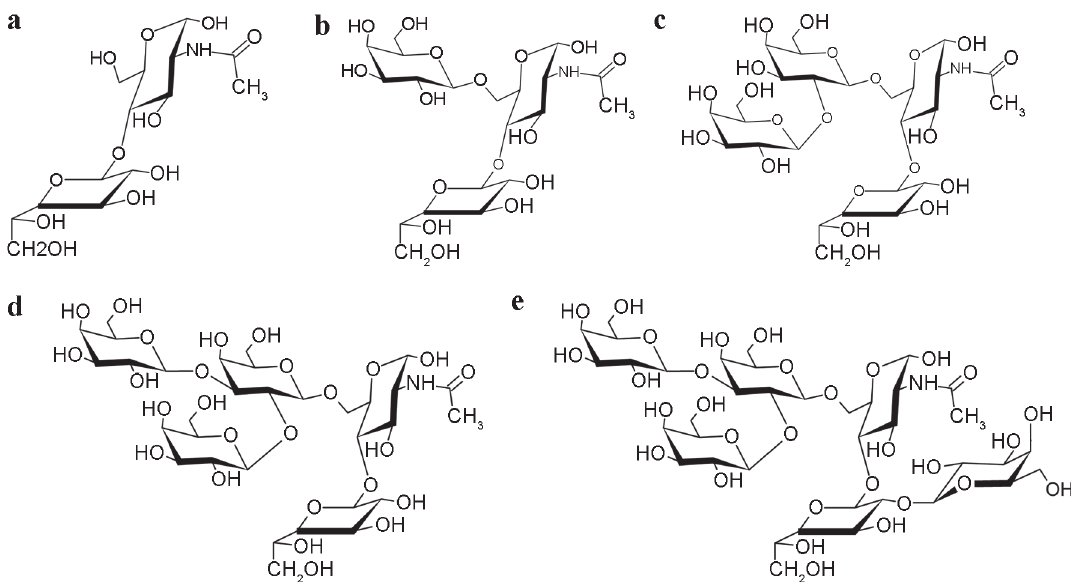
Figure 7 - Representation of O -glycan structures from mucins of epimastigotes from T. cruzi strain Silvio X10/1. a - monosaccharide alditol; b - disaccharide alditol; c - trisaccharide alditol; d - tetrasaccharide alditol and e - pentasaccharide alditol.